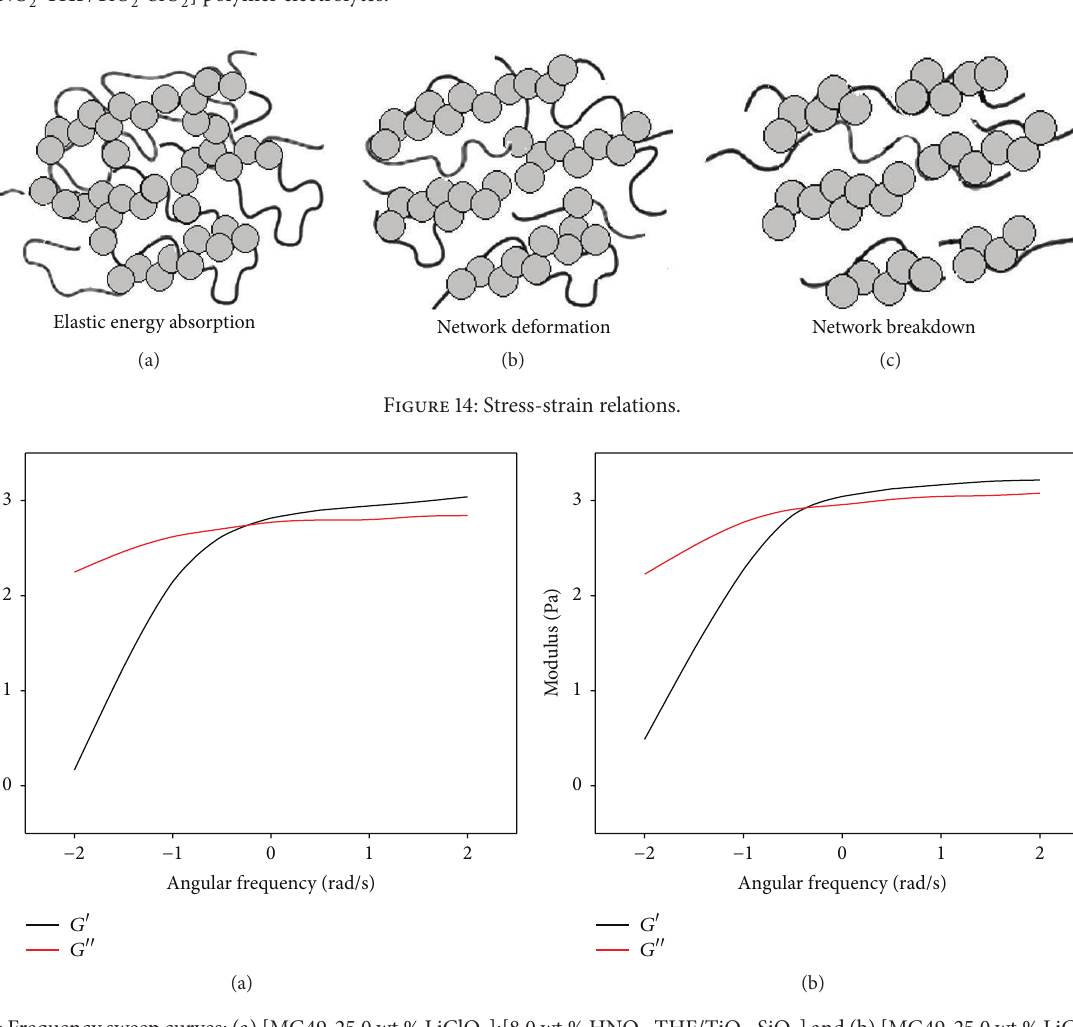
Figure 15: Frequency sweep curves: (a) [MG49-25.0 wt.% LiClO 4 ]:[8.0 wt.% HNO 3 -THF/TiO 2 -SiO 2 ] and (b) [MG49-25.0 wt.% LiClO 4 ]:[8.0 wt.% ClHNO 2 -THF/TiO 2 -SiO 2 ] polymer